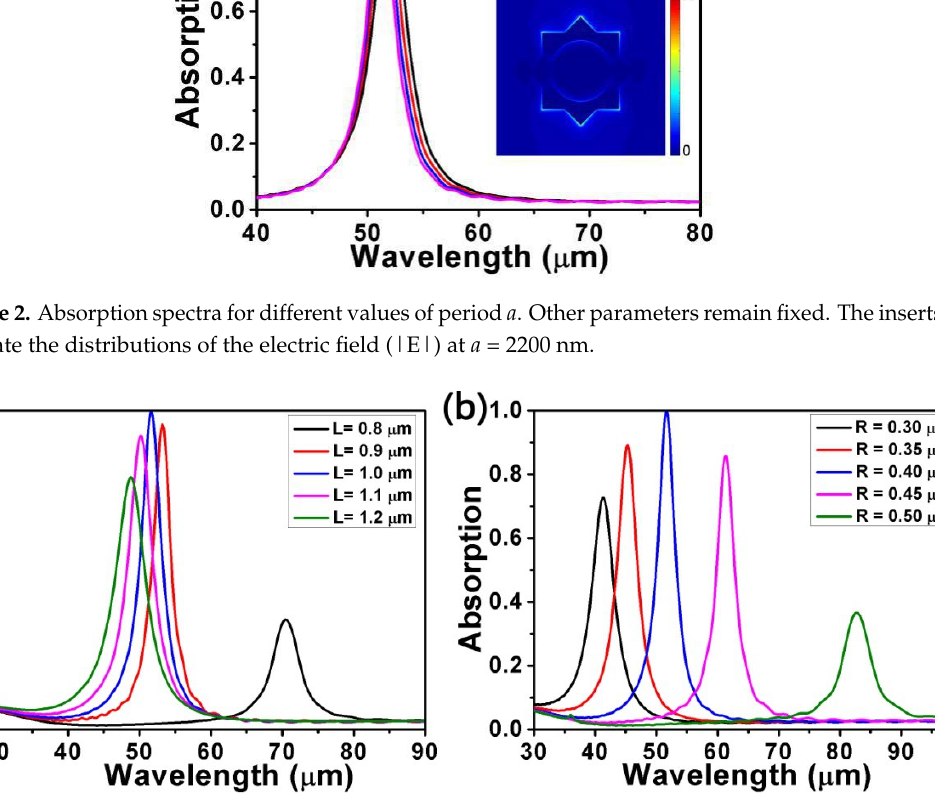
Figure 2. Absorption spectra for different values of period a . Other parameters remain fixed. The inserts indicate the distributions of the electric field (|E|) at a = 2200 nm.